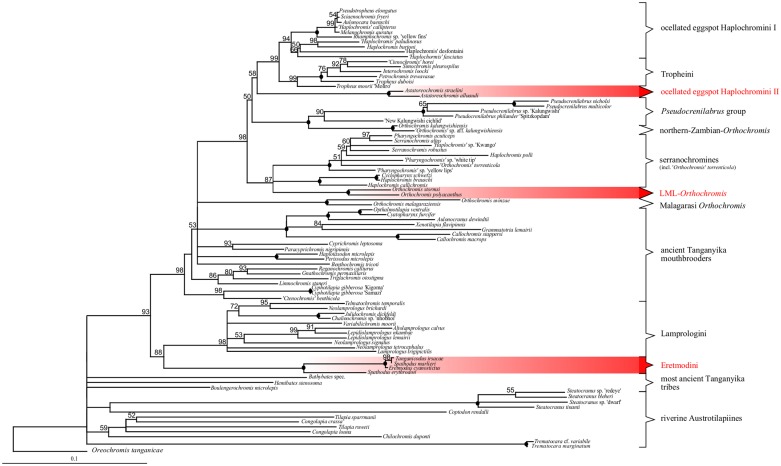
ML- phylogeny of mt sequence data and significant cyto-nuclear discordances.The topology of the best scoring ML tree is based on ND2 sequences (1010bp). Numbers at nodes refer to bootstrap-values (BS 500 replicates), 100% BS support is indicated by filled, black circles. Significant deviations from the nc-based NJ-topology are highlighted in red.